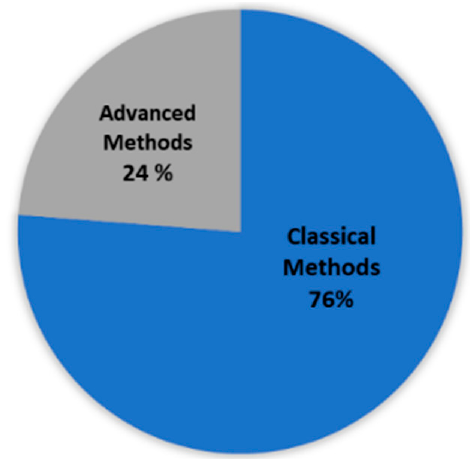
Figure 6. Representation of the main inversion techniques applied for pore structure characteriza ‐ on shale systems (Elaborated from analysis of articles in the attached Excel tion on shale systems (Elaborated from analysis of articles in the attached Excel file).